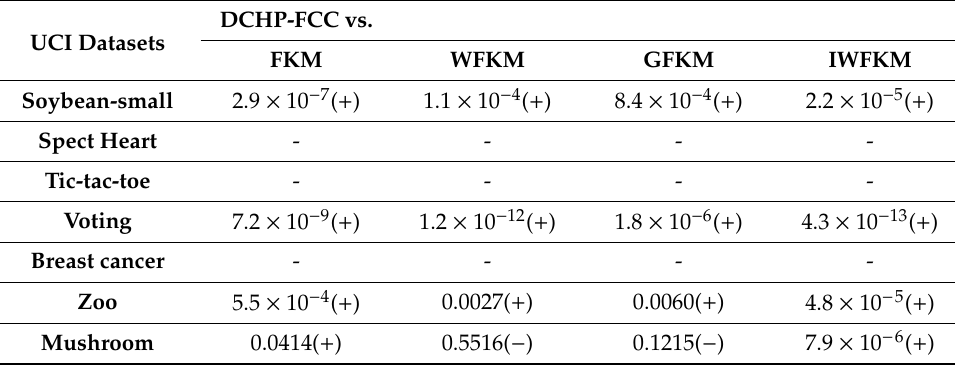
Table 6. The p -value produced by the T -test in terms of ACC.